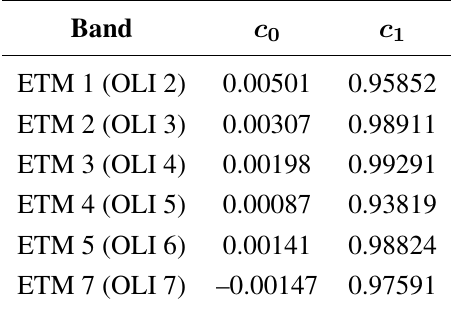
= c + c ρ . ETM+ 0 1 OLI